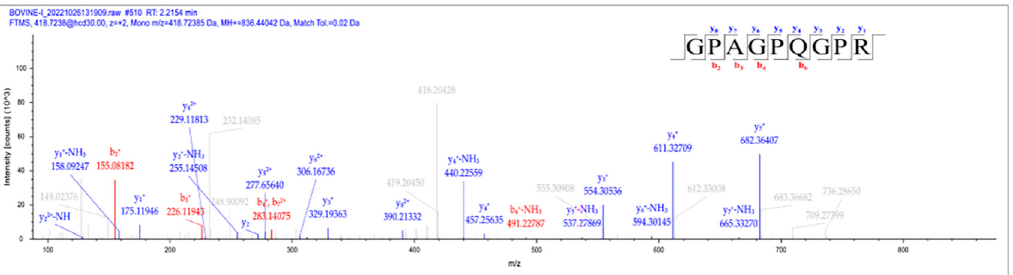
Figure 5. MS/MS spectrum of m/z 418.721 detected in digested bovine type I collagen reference ma- terial.